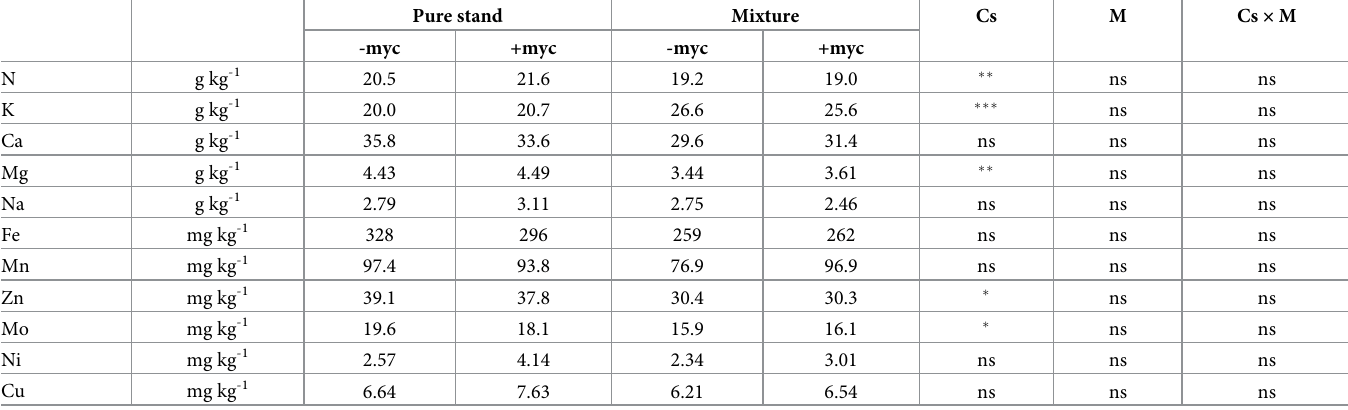
Table 2. Contents of macro- and microelements in faba bean grown in pure stand or in mixture in the absence (–myc) or presence (+myc) of arbuscular mycorrhizal fungi. Cs, cropping system (pure stand, mixture); M, absence or presence of AMF. Pure